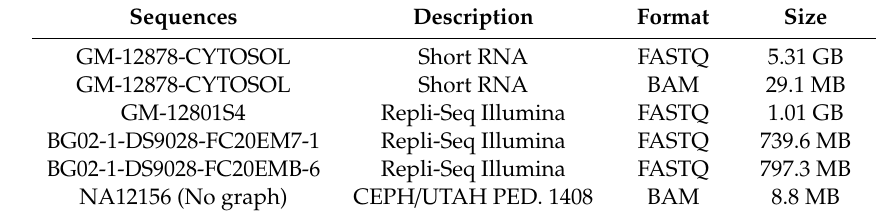
Table 1. Test data set.